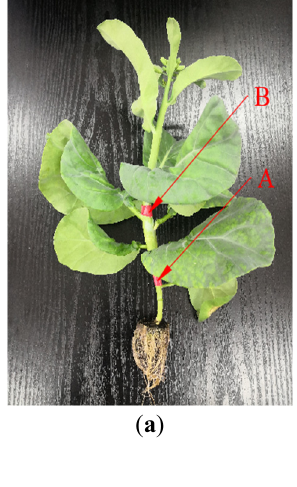
Figure 13. Data collection method in grasping test: ( a ) the illustration of red points A and B marked on the hydroponic Chinese kale, ( b ) the illustration of parameters setting interface in the motion analysis software Molysis, and ( c ) the definition method of the grasping inclination angle Φ g in the grabbing test.